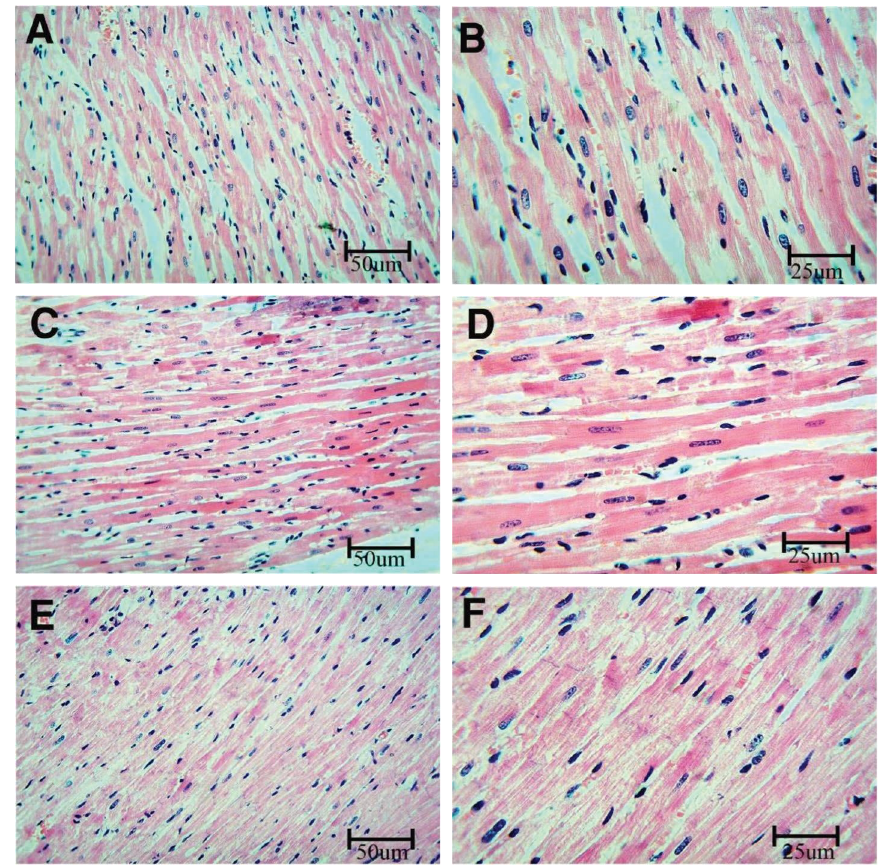
Figure 2: Histopathological section in the heart of rat stained with hematoxylin and eosin. a and b are the control group, c and d are the BPA group, and e and f are the BPA LC group. Te sections of the BPA show congested blood vessels and infltration by polynuclear cells. Tis picture is not marked in the BPA+ LC group (HE stain; A, C, E, G, I, and K X 200; B, D, F, H, J, and L X